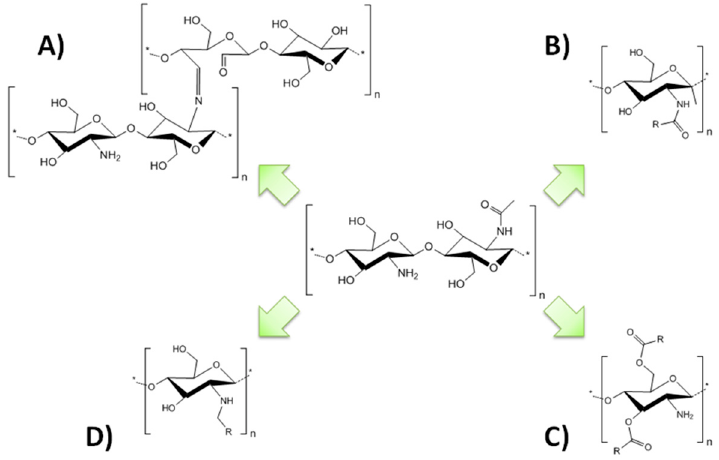
Figure 19. Some examples of chitosan derivatization made in IL. ( A ) Chitosan-graft-oxicellulose, ( B ) N -acylation, ( C ) O -acylation, and ( D ) Alkylation.